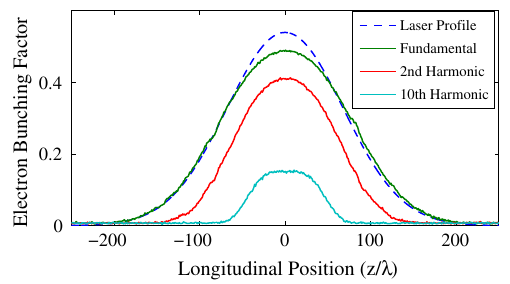
FIG. 5. Slice electron bunching factor and laser E field as a function of longitudinal position. Each bunching factor point corresponds to a slice of the electron bunch of width (cid:1) L [Eq. (6)].